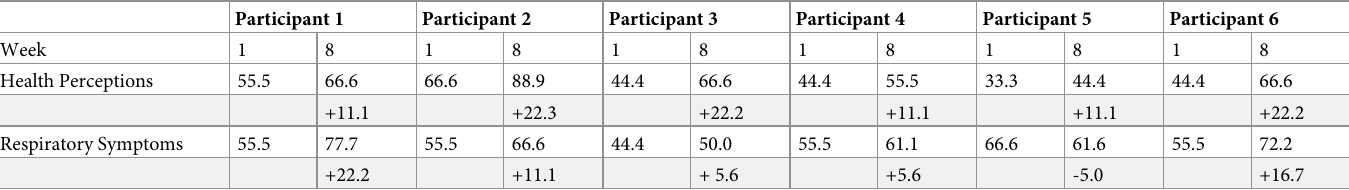
Table 1. Self-reported HRQoL (CFQ-R) at baseline (week 1) and end of study (week